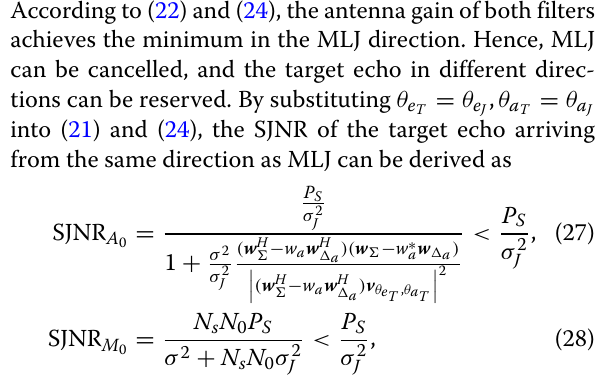
Table 1 Parameters for theoretical performance comparison Variable